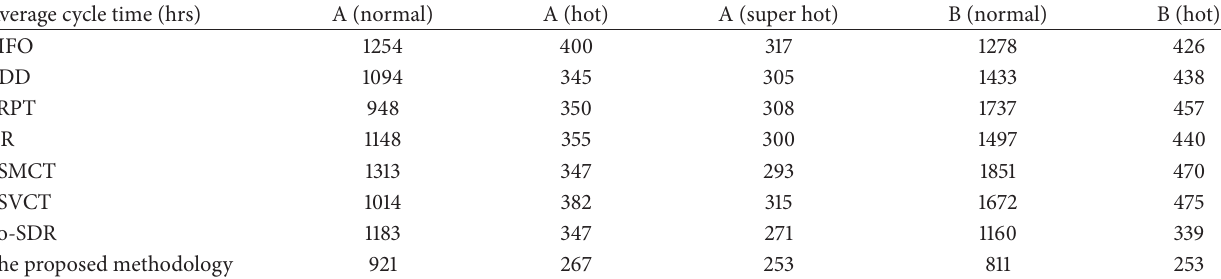
Table 7: The performances of various approaches in the average cycle